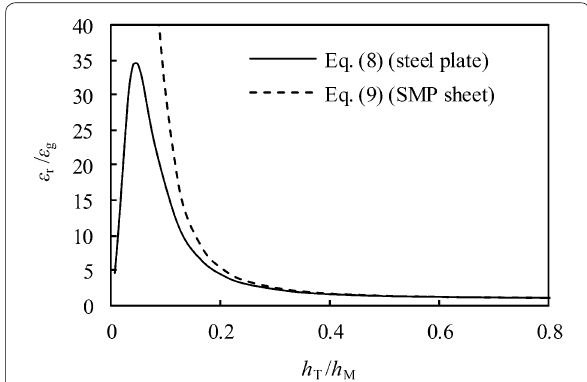
Fig. 9 Relationship between thickness ( h T / h M ) and strain ratios ( ε r / ε g ) of second prototype sensor [theoretical value predicted by Eq. (8)]. Theoretical value predicted by Eq. (9) is also shown by dotted curve